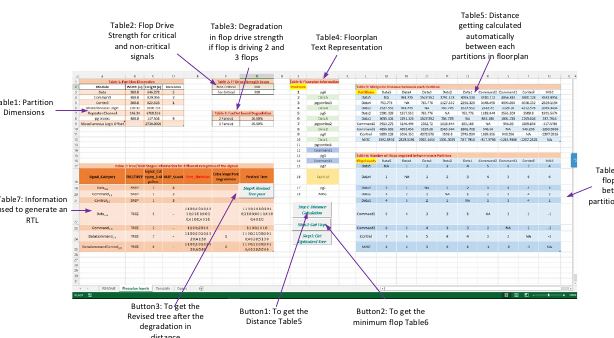
Table4: Floorplan Text Representation